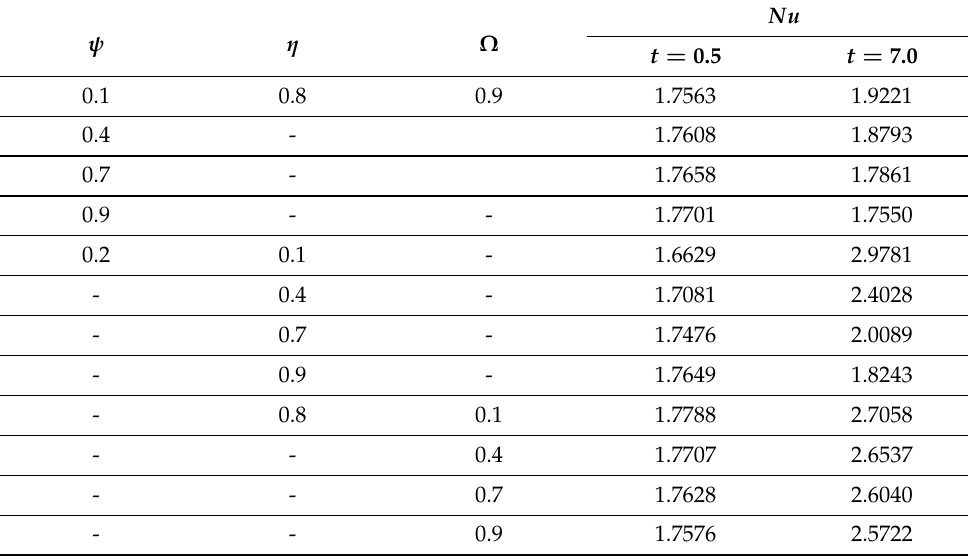
Table 6. Investigation of Nu for various values of ψ , η , and Ω .